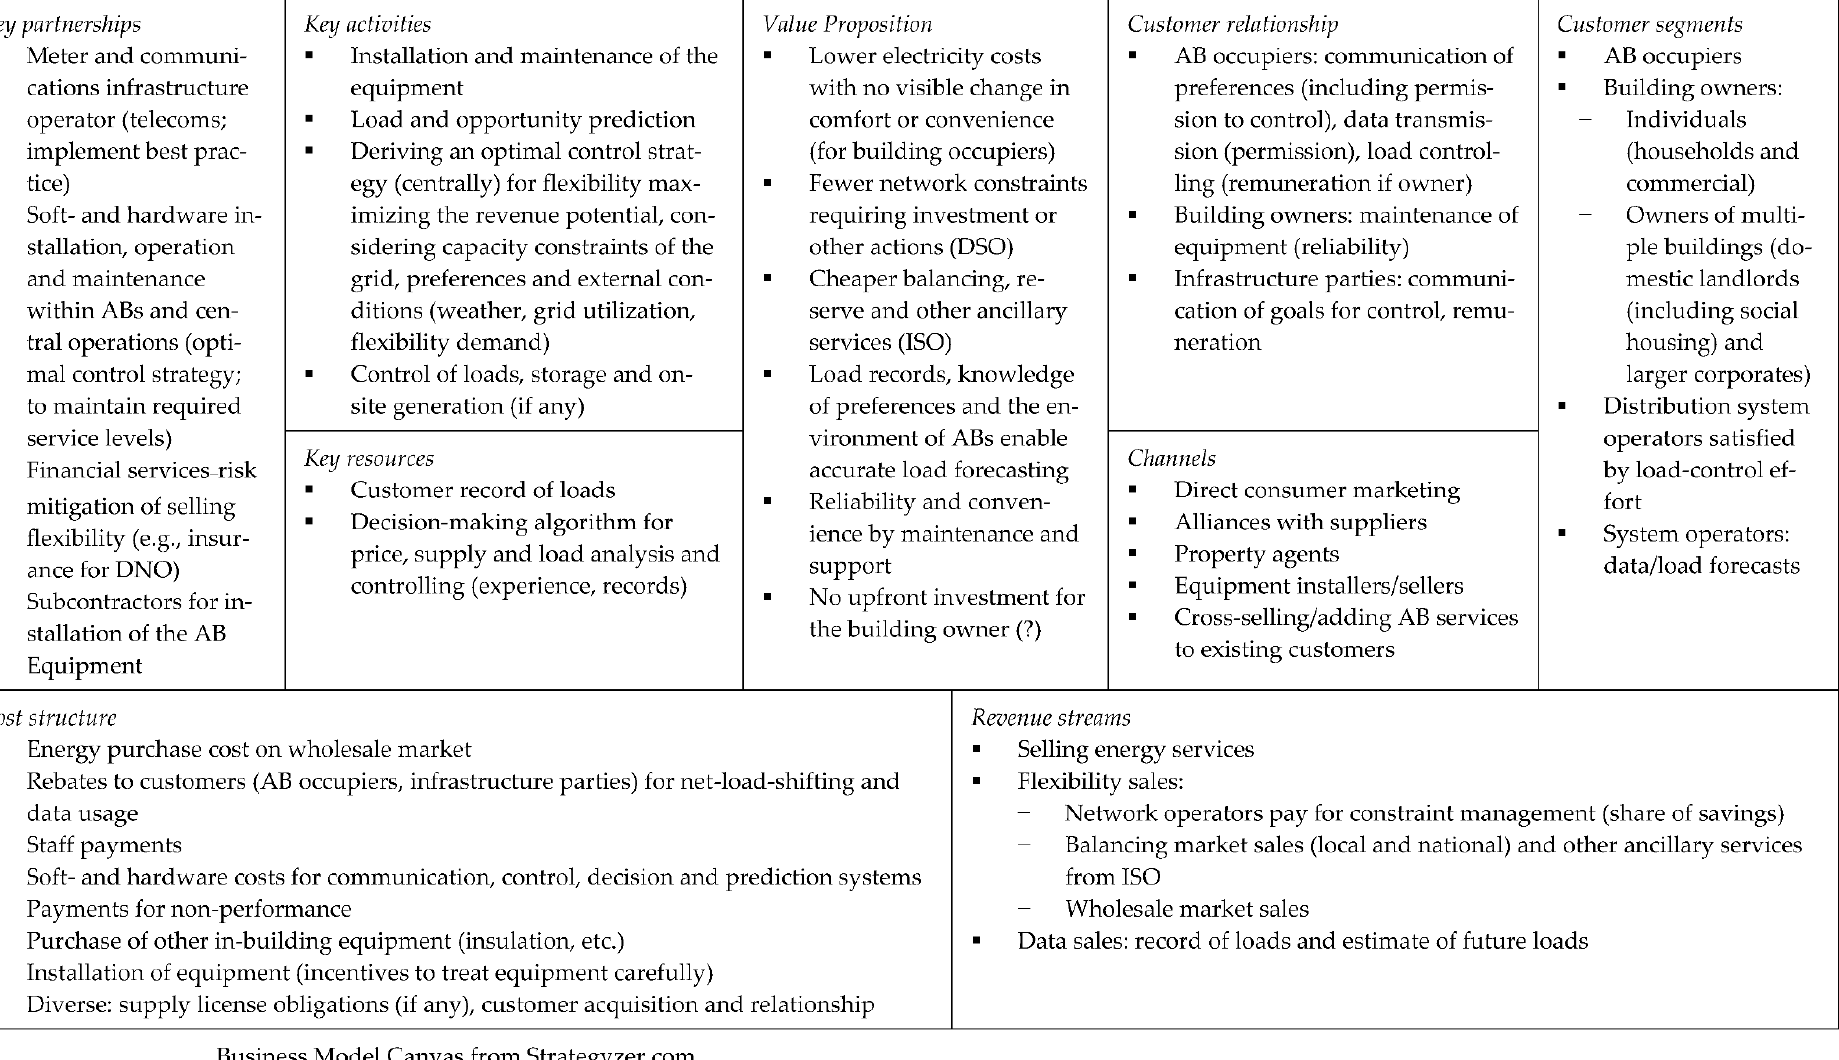
Figure 5. The AB-Energy Service Company.